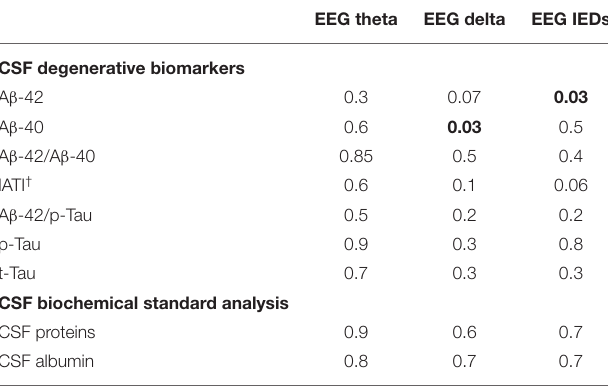
TABLE 4 | Correlations ( p -values) between biological and electrical features of the prodromal AD cohort